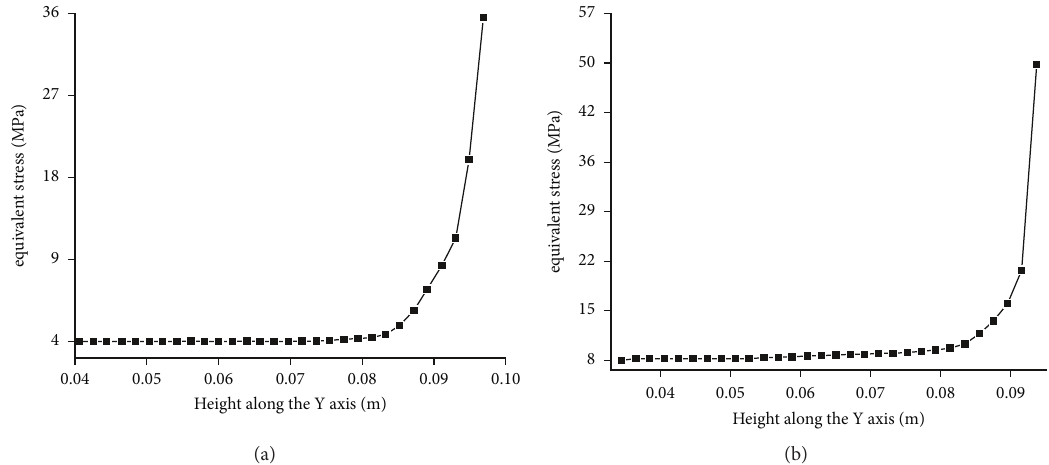
Figure 25: Distribution of equivalent stress along the height in equilibrium. (a) Distribution of equivalent stress along the height in equilibrium about Line 1. (b) Distribution of equivalent stress along the height in equilibrium about Line